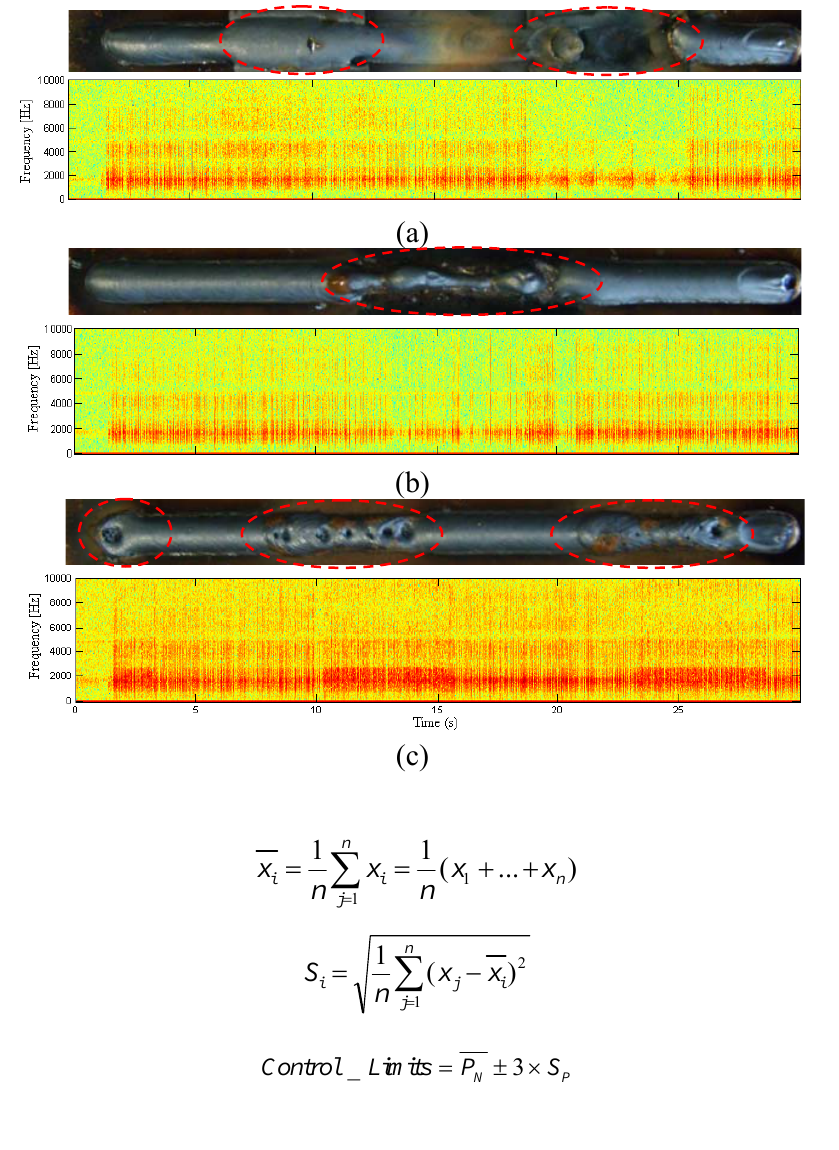
Figure 10. Welding Arc Sound